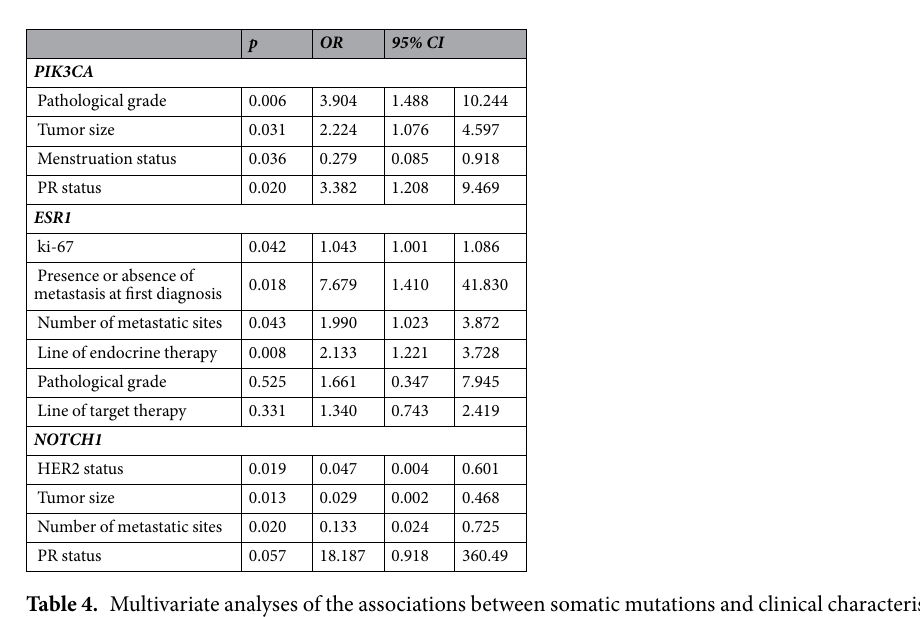
Figure 3. The frequency of common genes in four subtypes among 100 patients. ( A ) The frequency of common genes in different HER2 statues. Four gene mutations including TP53/PIK3CA/ERBB2/ESR1 detected more than 10 patients and NOTCH1 which differential detected between different HER2 statues patients listed to the bottom the figure. HER2 positive and negative patients are colored yellow and blue respectively. ( B ) The frequency of common genes in different HR statues patients. Four gene mutations including TP53/PIK3CA/ ERBB2/ESR1 detected more than 10 patients listed to the bottom of the figure. HR positive and negative patients are colored yellow and blue respectively. Whiskers correspond to the percentage Standard Error of the gene frequency.